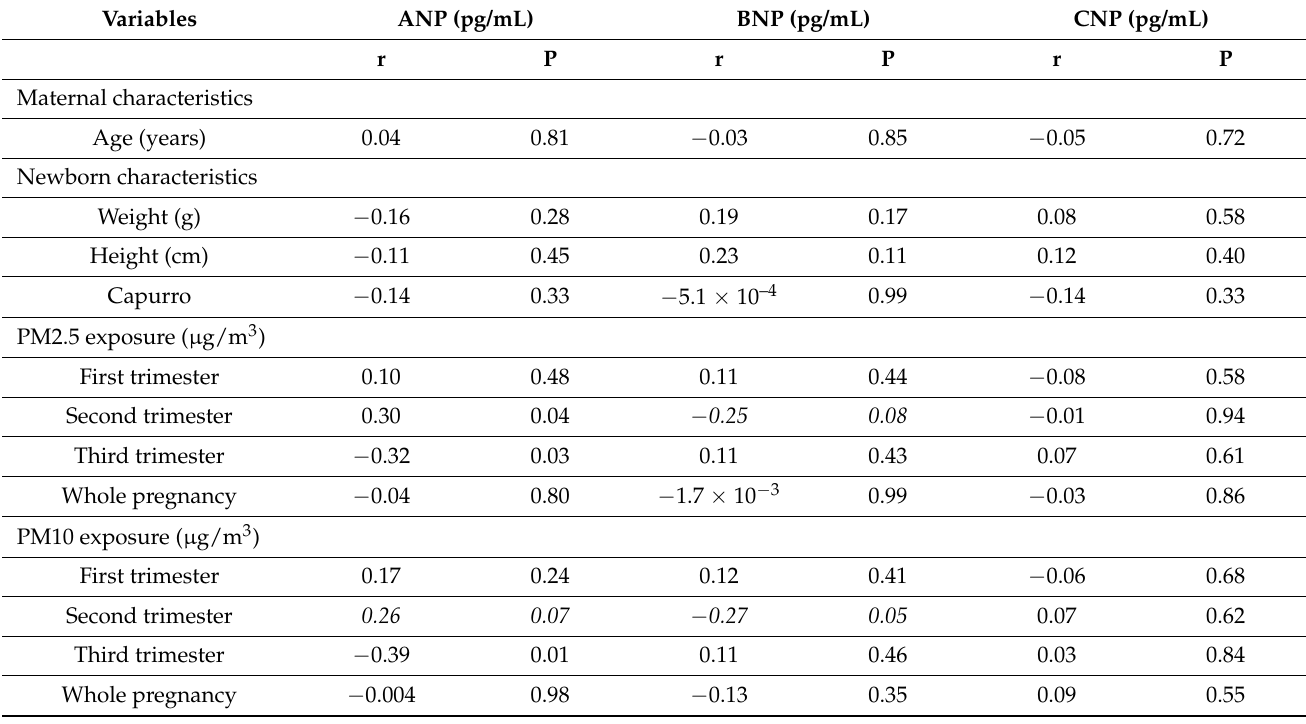
Table 3. Spearman’s correlations between plasma natriuretic peptides, maternal and newborn characteristics and particulate matter